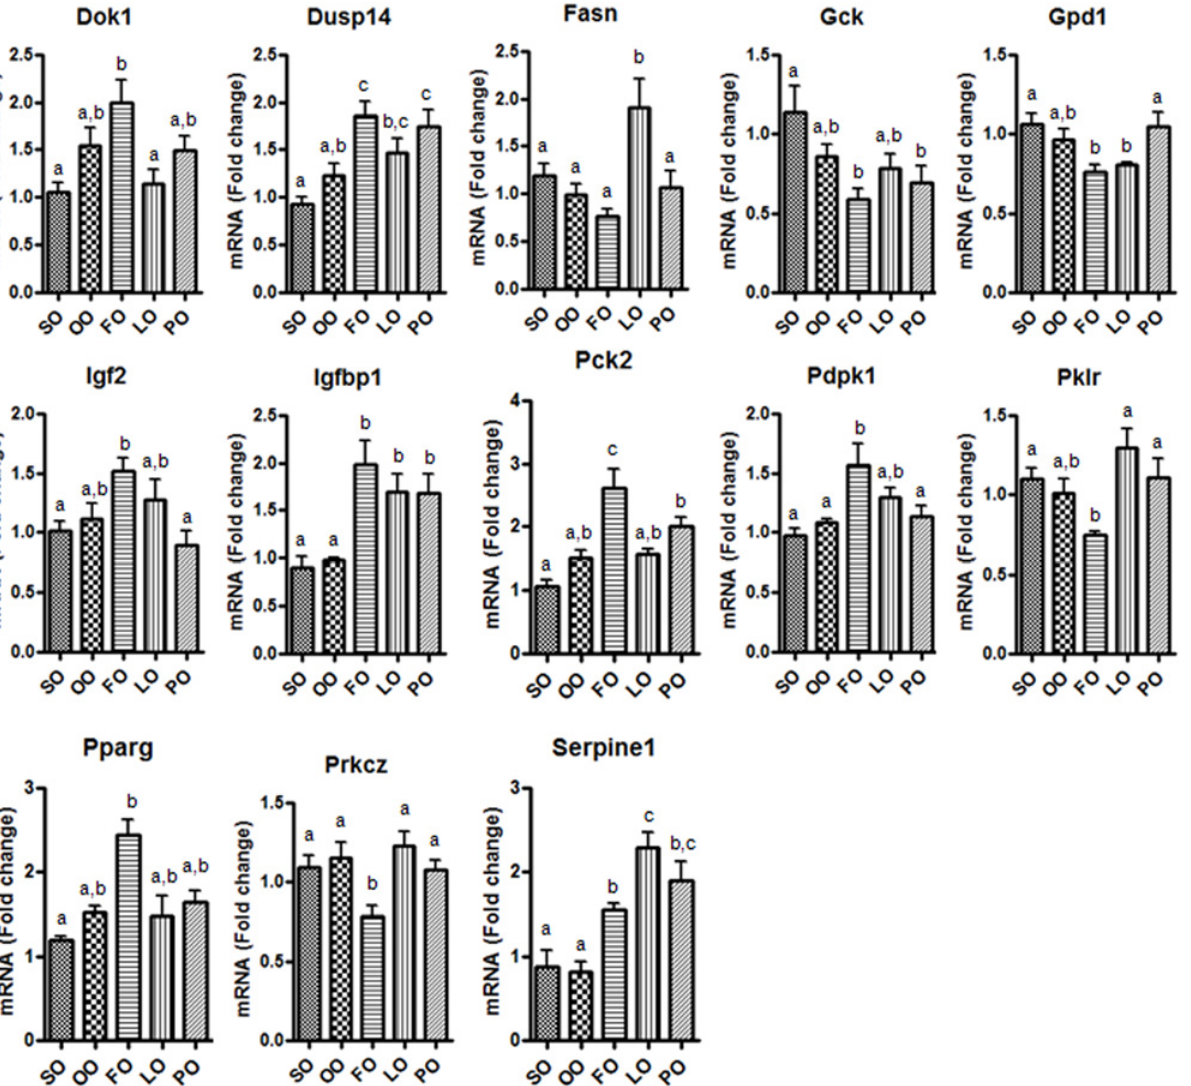
Fig 4. Expression levels selected genes related to insulin signaling in liver of adult pups according to their mother ’ s dietary treatment during the first 12 days of pregnancy. Data is expressed as fold change (mean ± SEM) relative to soybean (SO) diet group. Olive (OO) diet; fish (FO) diet; linseed (LO) diet; or palm-oil (PO) diet. Different letters in the same graph means statistical difference (P < 0.05) between dietary groups. Animals per group n =